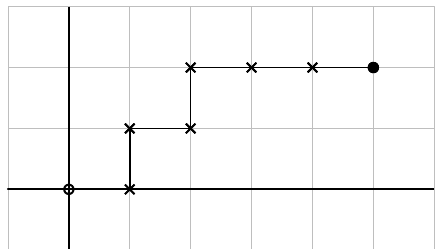
Figure 5. The structure of zeros and poles of the generating function 0 ( u ) for the vacuum representation of Y 5 ; 2 ; 0 [(cid:9)]. We draw one example of the snake con(cid:12)guration connecting the zero and the pole.